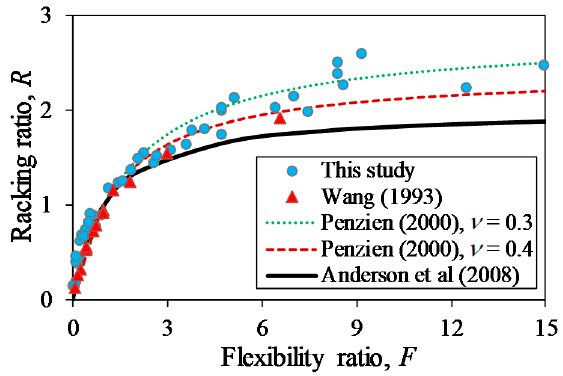
Figure 4. Comparison of racking ratio and flexibility ratio relationships.